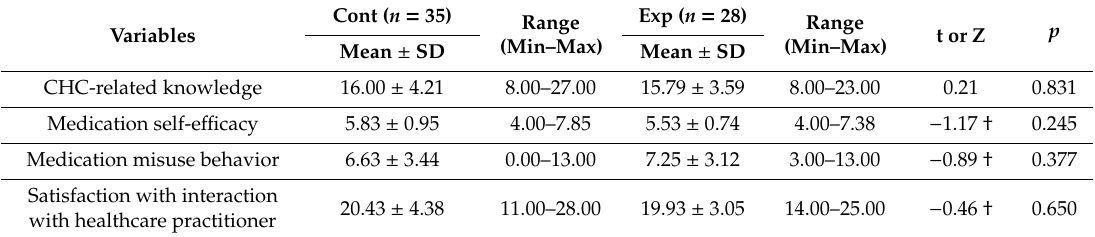
Table 3. Homogeneity test of dependent variables ( N = 63).